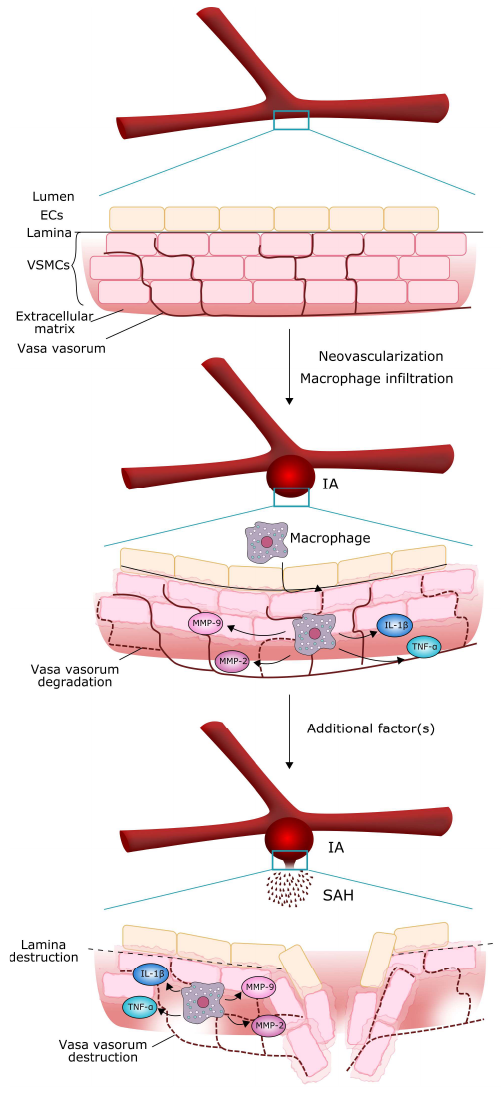
Figure 1. Molecular mechanism of intracranial aneurysm (IA) growth and rupture. Neovascularization (dashed thin red lines) of the vasa vasorum (solid thin red lines) in vascular smooth muscle cells (VSMCs) enables macrophages and other inflammatory cells to penetrate the vessel wall through the layer of endothelial cells (ECs) and secrete substances, mostly proteases, thus thinning and weakening the wall. Such structure of the vessel can rupture, resulting in subarachnoid hemorrhage (SAH), but a trigger, mostly unidentified, is needed to initiate this effect.